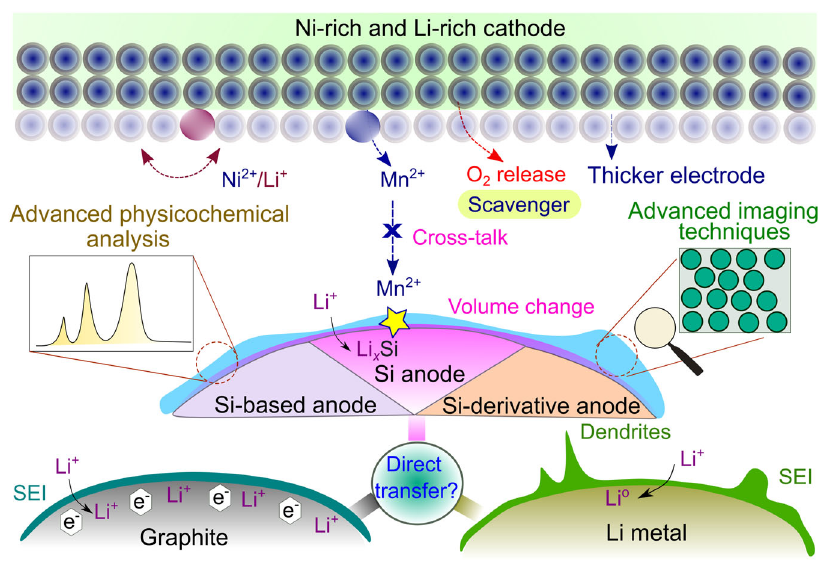
Fig. 7 Challenges and solutions for Si/Si-B/Si-D||IC cells. To implement this technology commercially, Si/Si-B/Si-D anodes suffer from a very large volume change, with ICs mostly hindered by their chemical/electrochemical instability (e.g. cation displacement, dissolution of transition metal ions, release of reactive oxygen, etc.). Shifting from the atomic/material level to the cell level, crosstalk between anode and cathode materials during continuous cycling and thick electrodes are required for high-energy batteries, although this may impose additional challenges for stabilising electrode/electrolyte interphases. In addition, the direct transfer of knowledge attained from graphite and Li metal-based rechargeable batteries to Si/Si-B/Si-D||IC systems is not straightforward. Solutions may involve advanced physicochemical analysis and imaging techniques to understand anode-electrolyte interphases as well as scavengers for capturing O 2